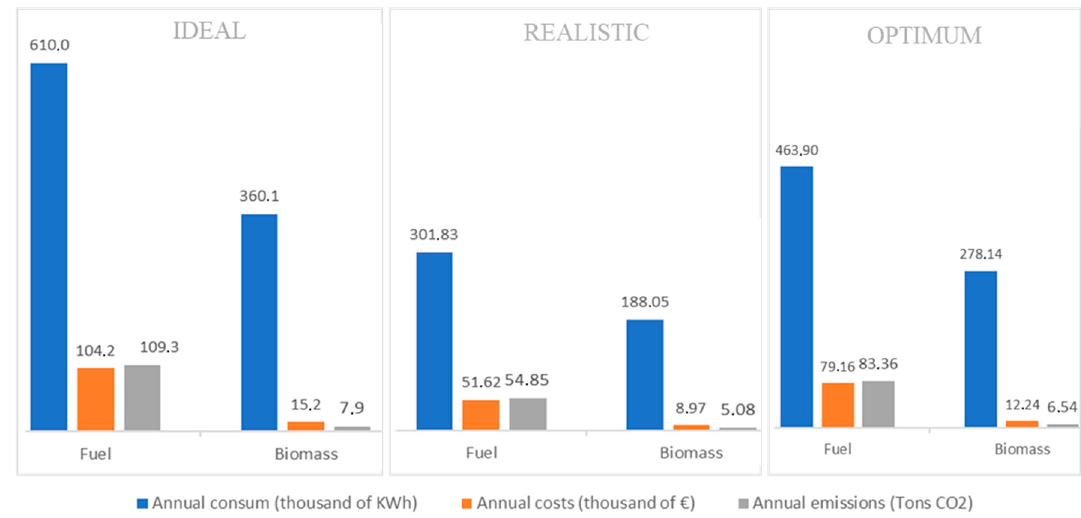
Figure 3. Comparative results in municipalities selected for Group I considering the three scenarios and biomass as alternative to the use of fuel (complete results in Table A11 in the Appendix A).